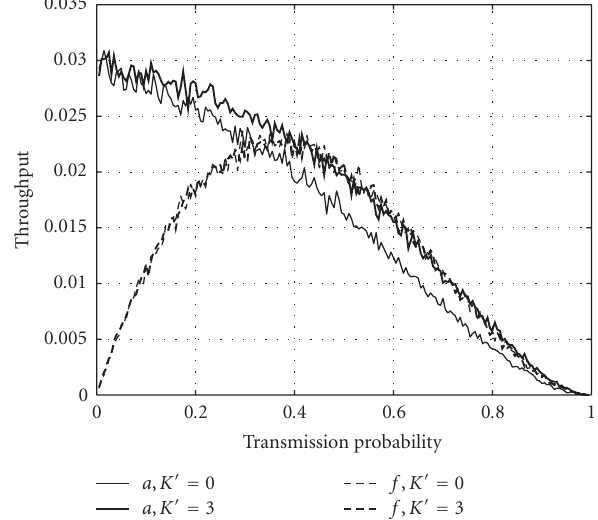
Figure 23: Throughput of the dynamic ( K (cid:5) = 3) and static ( K (cid:5) = 0) cases for K = 4 with a reset of K ( K (cid:5) = 3) on node 7 of connection f (asymmetric network of Figure